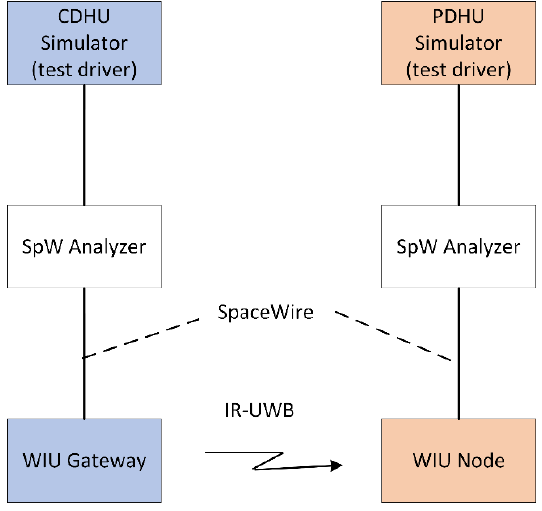
Figure 2. System architecture: wired-to-wireless requirements.